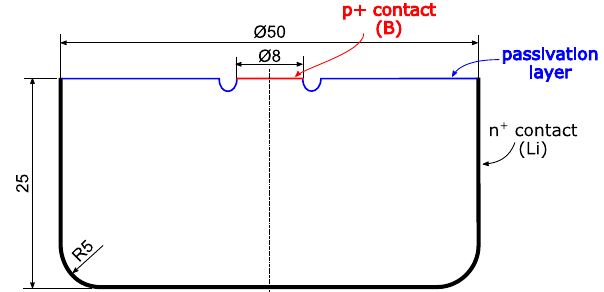
Fig. 1 Schemeofthemanufacturedprototypedetector.Thethickblack line represents the n + contact created by the lithium thermodiffusion. The red and blue lines represent the p + electrode implanted with boron and the passivated surface, respectively. Dimensions are given in